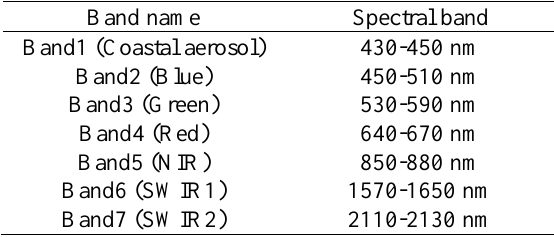
Table1: Band information of Landsat-8 OLI